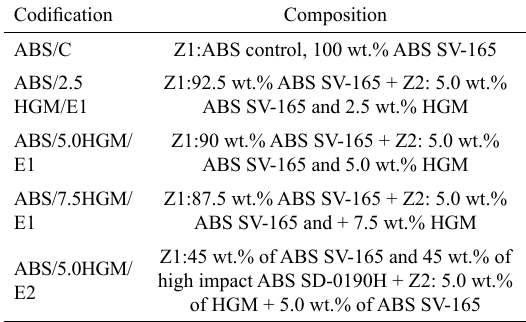
Table 1. Codification and composition of the ABS and ABS/HGM